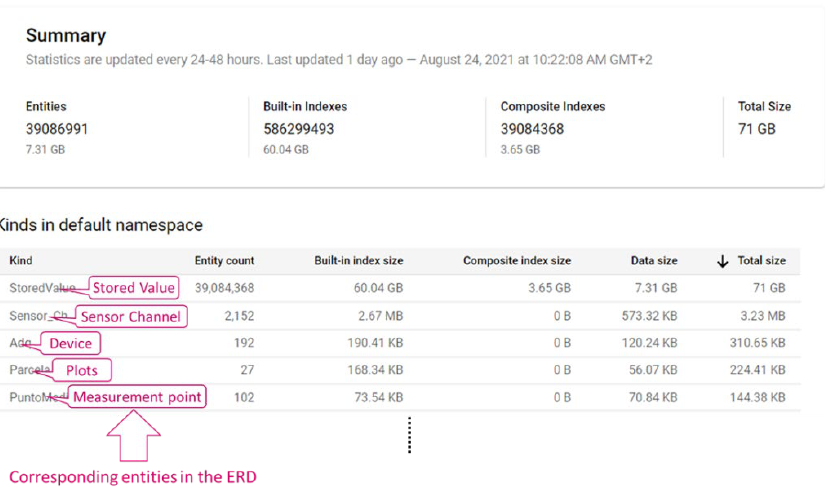
Figure 15. Summary of statistics about the use of the Datastore, while the application is running in the backend for all the users. Information about number of stored entities, data size and global size is automatically calculated.